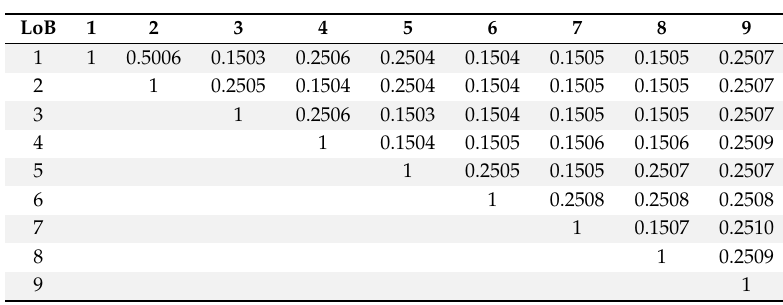
Table 9. Correlation block for the marginalized model: Ω CY , s